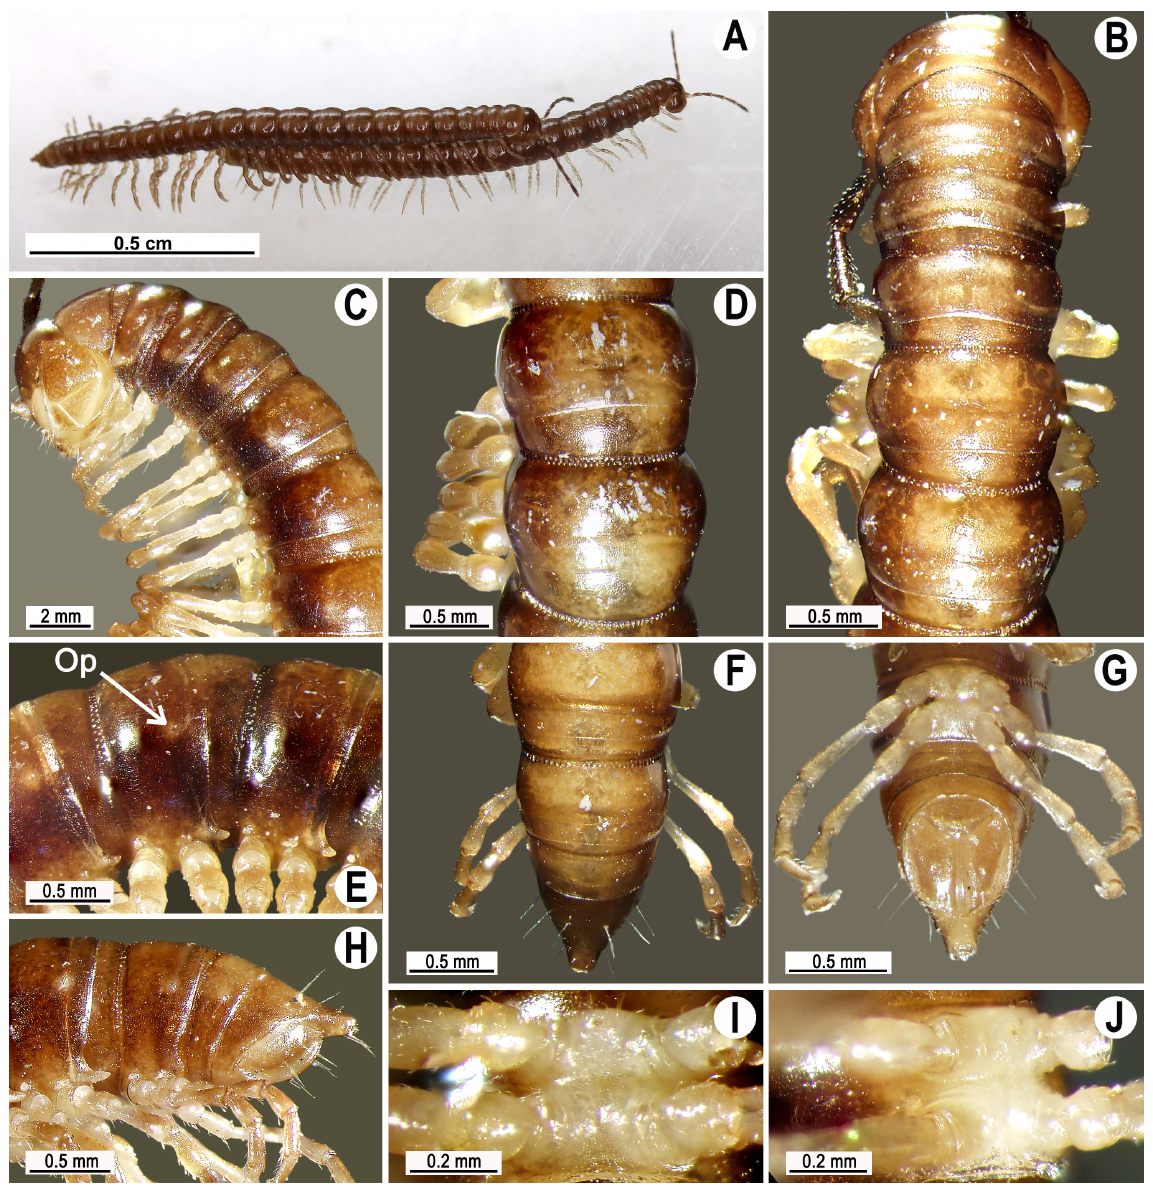
Fig. 4. Tylopus hongkhraiensis sp. nov., holotype, ♂ ( B–J ), paratypes, ♂, ♀ ( A ). A . habitus, live coloration. B–C . anterior part of body, dorsal and lateral views, respectively. D–E . Segments 10 and 11, dorsal and lateral views, respectively. F–H . Posterior part of body, dorsal, ventral and lateral views, respectively I–J . Sternal cones between coxae 4, subcaudal and sublateral views, respectively. abbreviations are explained in the